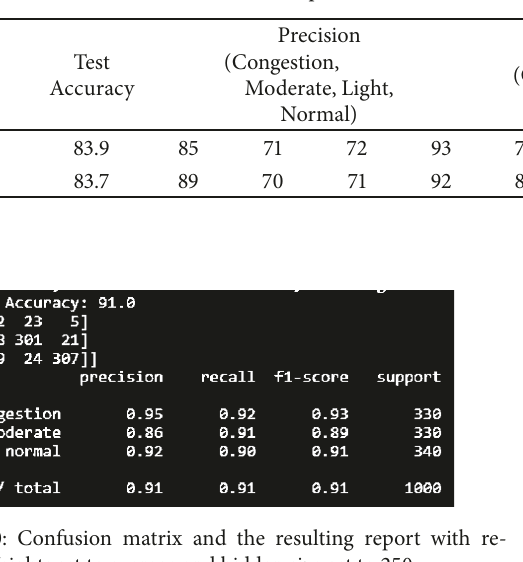
Table 4: A comparison between two models with different sequence of time step.